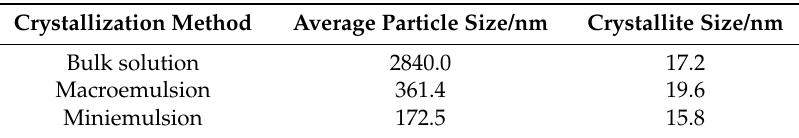
Table 1. Average particle size measured by dynamic light scattering and crystallite size calculated by applying the Scherrer formula.